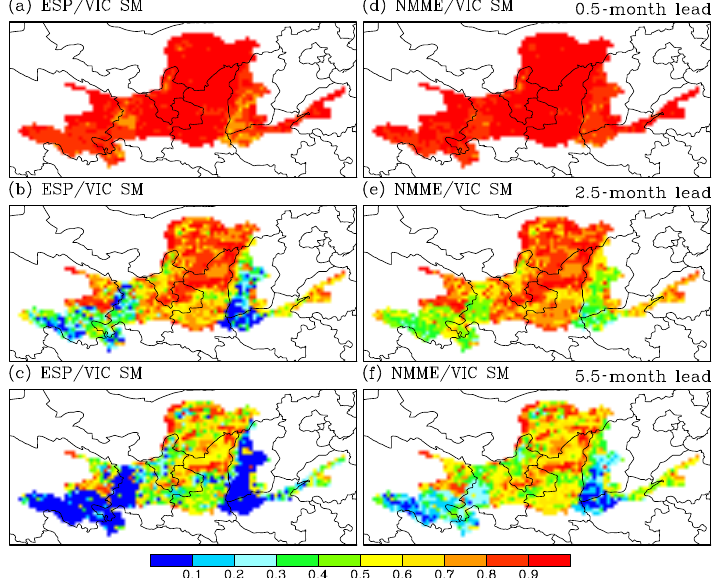
Figure 5. Spatial distributions of average AC of ensemble mean forecasts from ESP/VIC (left panel) and NMME/VIC (right panel) for monthly soil moisture at different leads. The average AC is the mean for the forecasts starting in 12 target